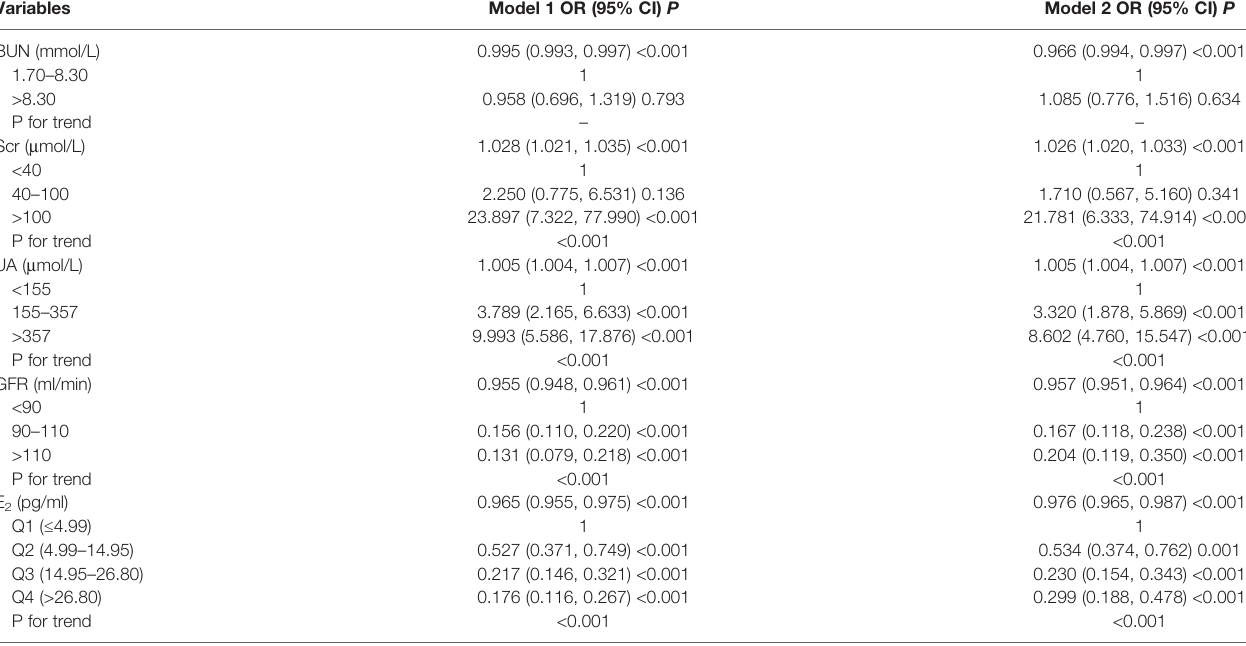
TABLE 3 | The relationship between renal function indexes and estradiol and hyperhomocysteinemia.